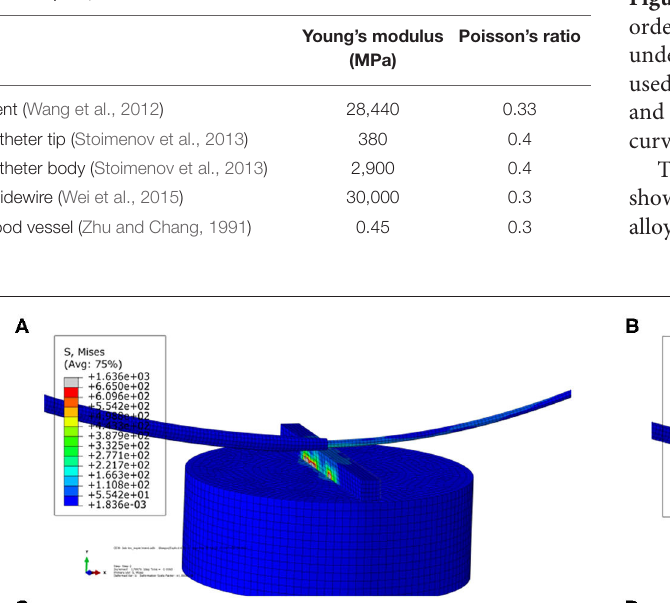
Frontiers in Physiology |